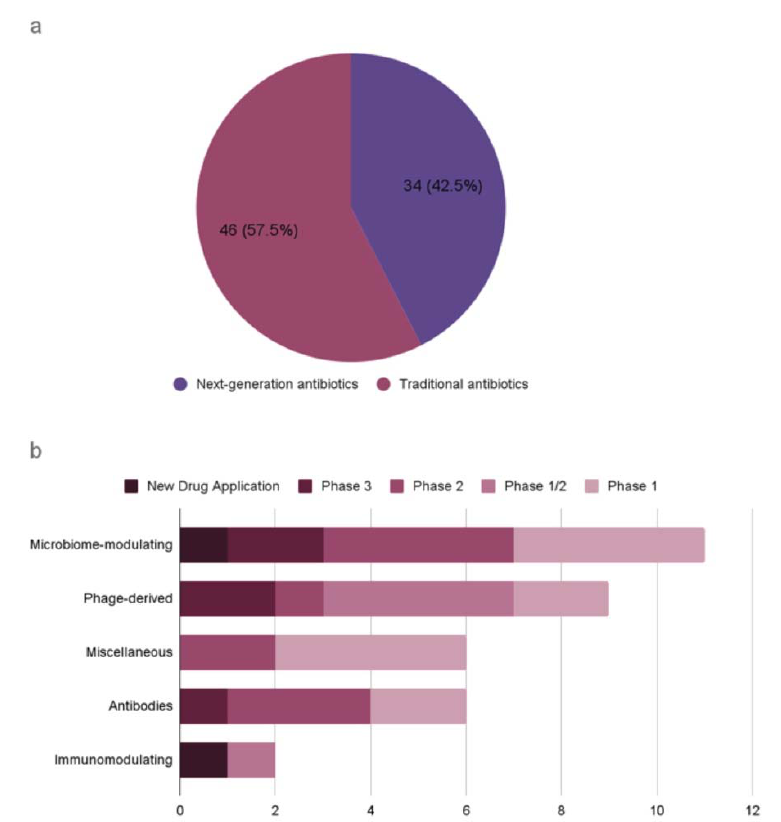
Figure 1. Antibiotics in clinical development according to the WHO analysis (published in